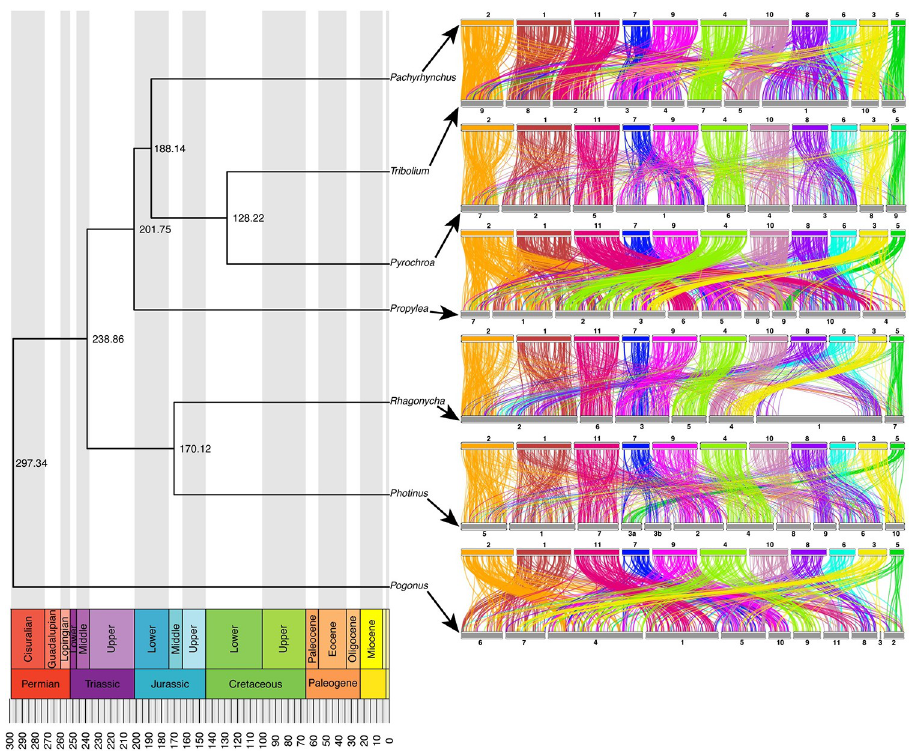
Fig 4. Chronogram and ideograms of 7 beetle genomes which have chromosome level assemblies. Chromosomes largely remain intact with few translocations relative to reshuffling within a chromosome. Colors correspond to the 11 chromosomes of Pachyrhynchus sulphureomaculatus , top row of ideogram plots. Each line represents a BUSCO gene connecting its position on the chromosome of P . sulphureomaculatus (top row, respectively) to its position on another species (lower row,